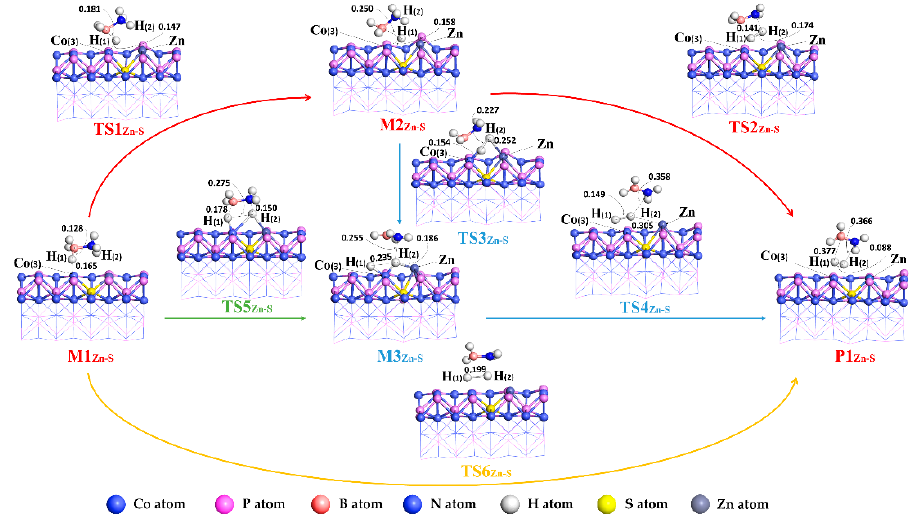
Figure 4. General flowchart of NH 3 BH 3 hydrogen production reaction on CoP Zn-N (101) surface.